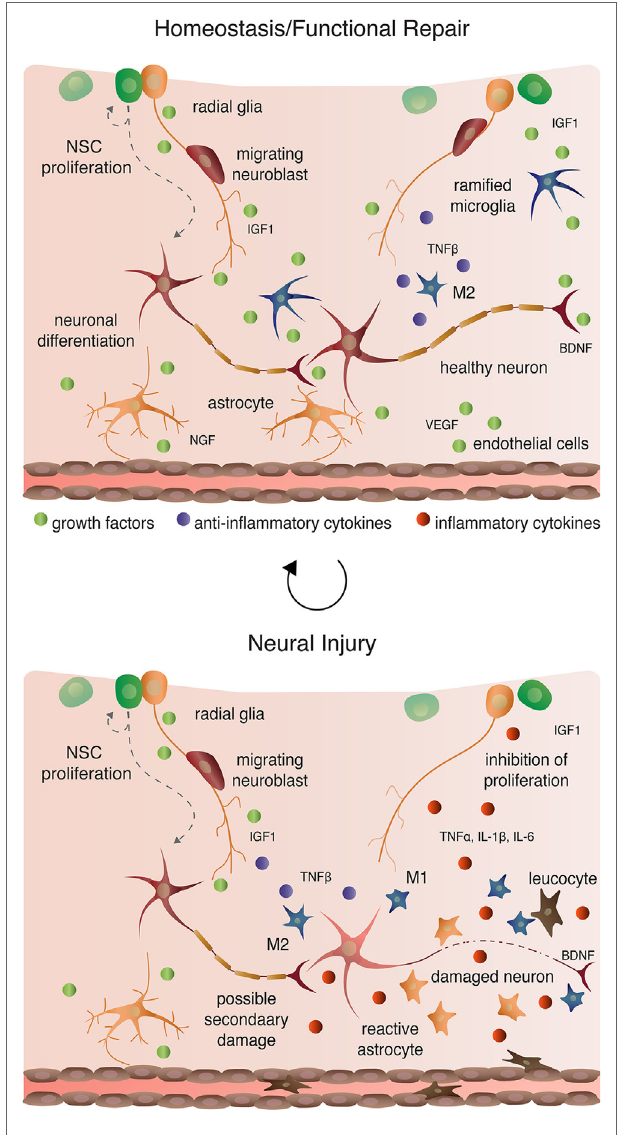
FiGURe 4 | Cellular interactions in homeostatic, injury-induced, and reparative